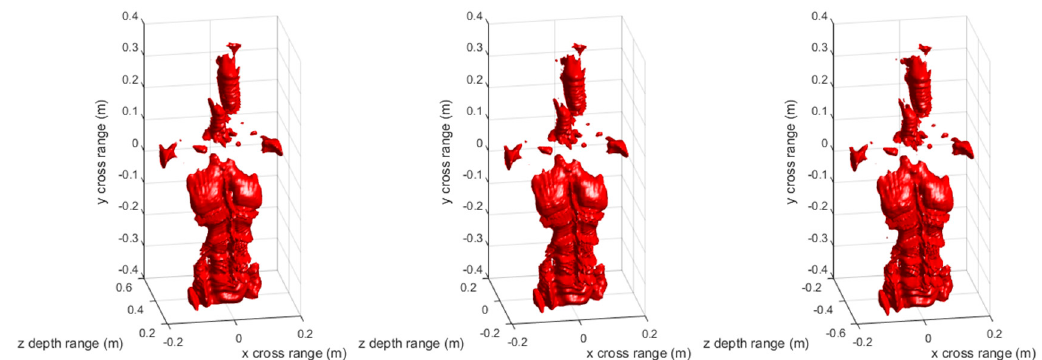
Figure 10. Three-dimensional imaging results of the mannequin by proposed FSA with compensation distance 0 ( left ), 0.43 m ( middle ), and 0.86 m ( right ).